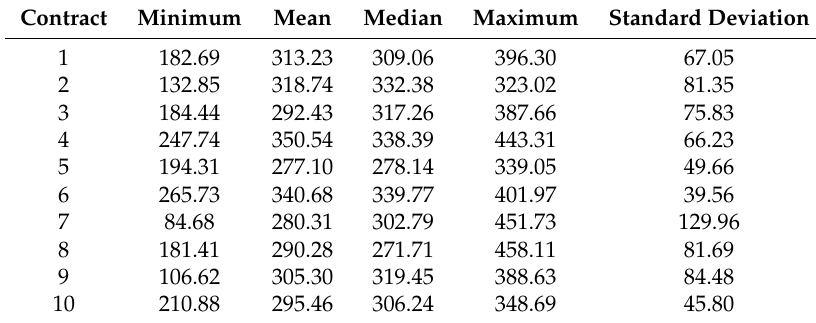
Table 2. Descriptive